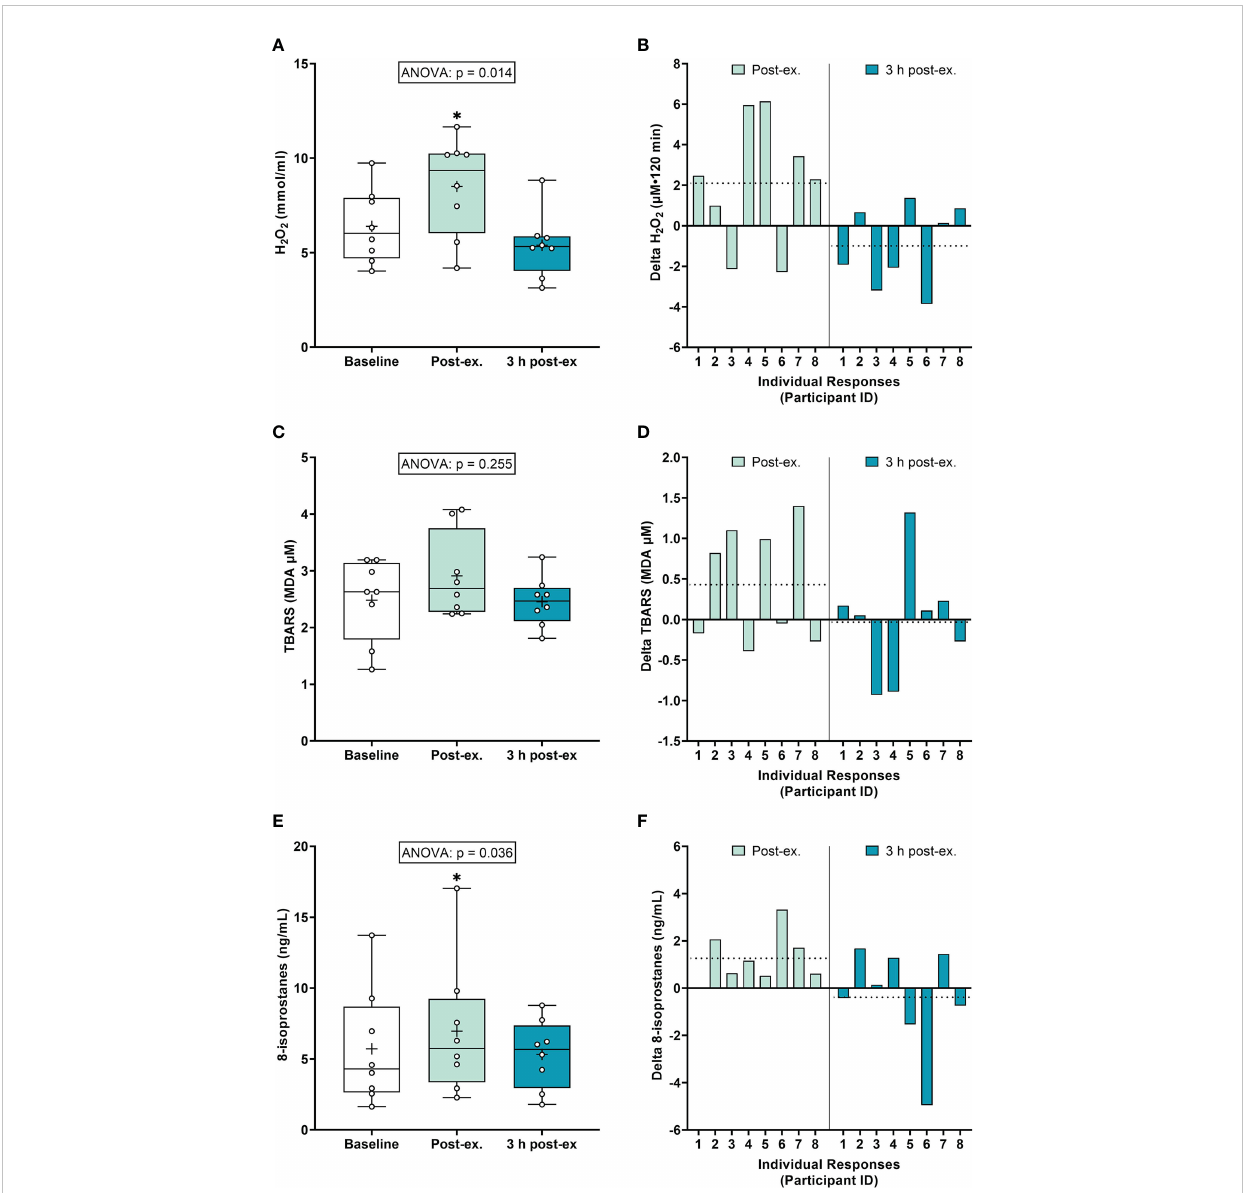
FIGURE 1 Plasma hydrogen peroxide (H 2 O 2 ) (A, B) , serum thiobarbituric acid reactive substances (TBARS) (C, D) , and 8-isoprostanes (E, F) at baseline, immediately after exercise, and 3 h post-exercise. Group averages and individual data (A, C, E) are presented as Box and Whisker plots. The Box represents the interquartile range alongside the median (line) and mean (plus symbol). The Whiskers represent the minimum and maximum range of the data. Individual responses (B, D, F) are presented as the delta change between baseline and post-exercise timepoints (immediately post-exercise and 3 h post-exercise). The dotted line represents the group average delta value. Data were analyzed using one-way ANOVA and Fishers LSD test for multiple comparisons. n = 8 participants. *p < 0.05 compared to